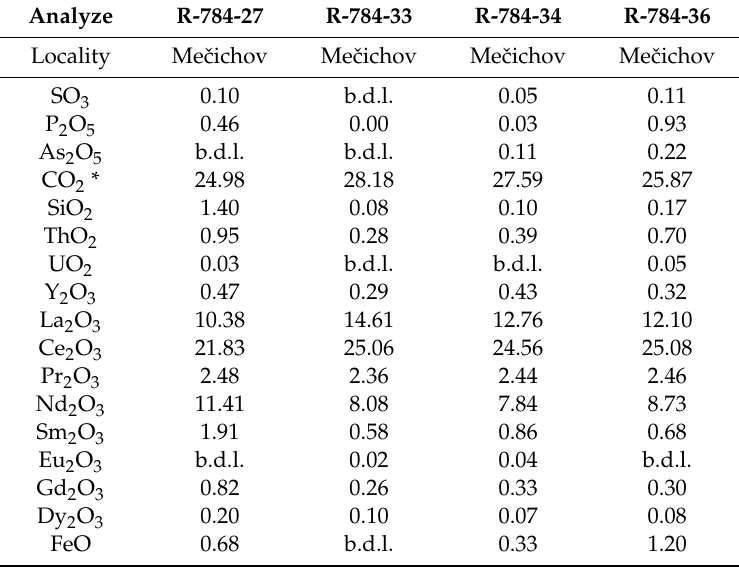
Table 3. Representative chemical analyses of synchysite (wt